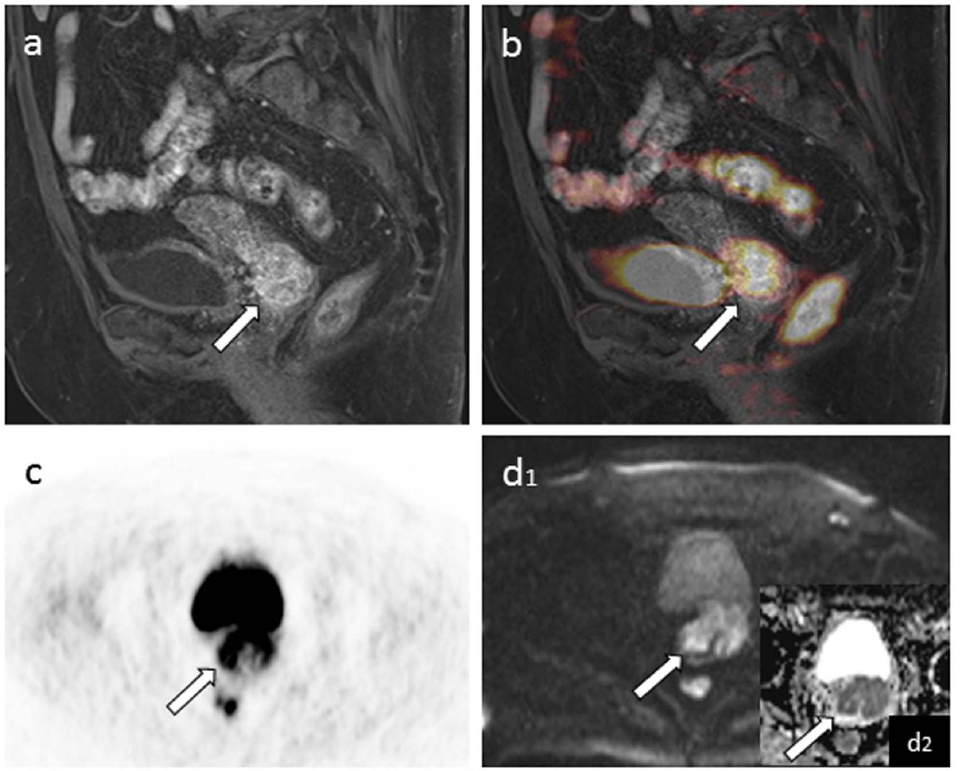
Figure 4. T1 weighted post-contrast sagittal 3D VIBE (a) and fused PET/MRI image (b) of an inhomogeneously contrast-enhancing and FDG avid cervical cancer lesion. Image c and d show corresponding tracer uptake in PET (c) and restricted diffusion in DWI (d 1 ) with low signal intensity on the corresponding ADC map (d 2 ).